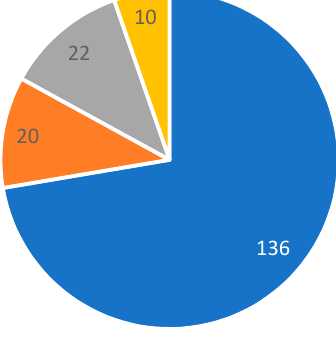
Figure 3. Analysis of the average number of cigarettes smoked per day based on the three most common cancer types at any time before cancer diagnosis and during the cancer treatment. Statistical significance in number of cigarettes smoked is registered both before ( χ 2 = 50.006, p = <0.001; H = 36.926, p = <0.001) and after cancer diagnosis ( χ 2 = 20.498, p = 0.009; H = 7.554, p = 0.023).